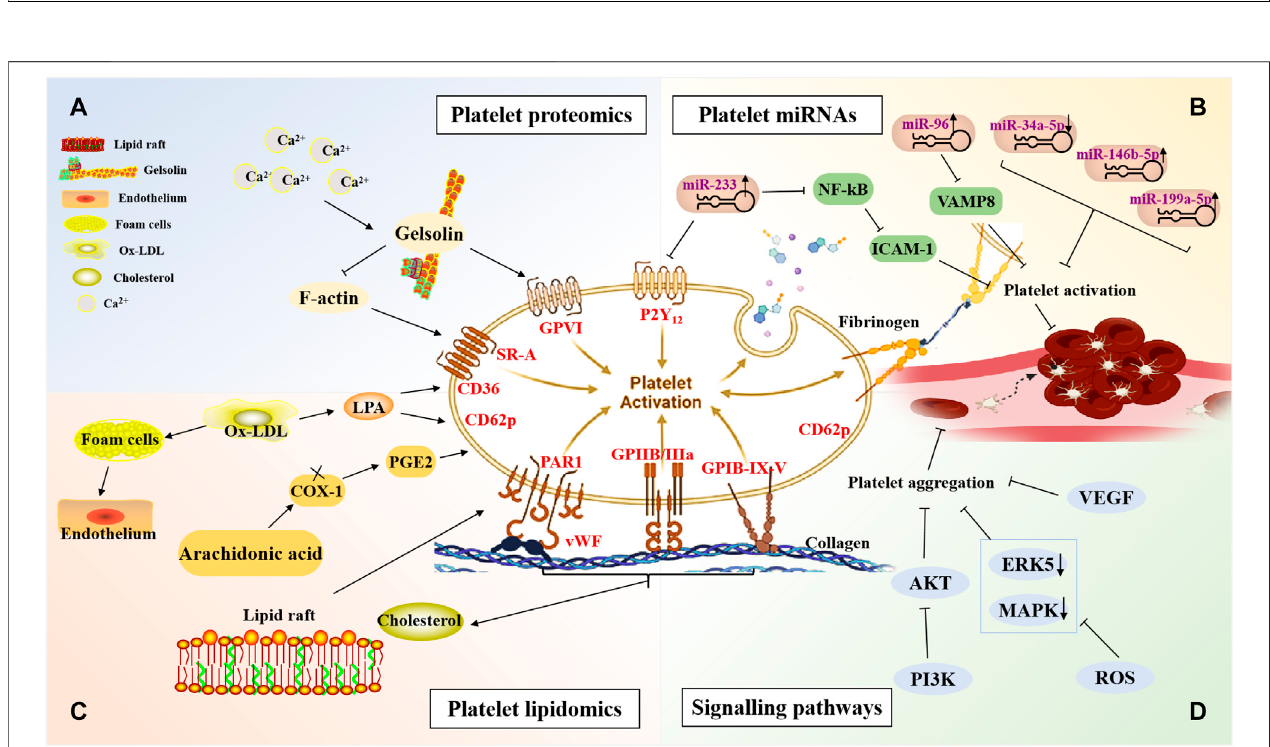
FIGURE 2 | The mechanisms against atherosclerotic cardiovascular diseases of blood-activating Chinese botanical drugs combined with anti-platelet drugs via platelet-related targets. This fi gure was created using BioRender.com. (A) The mechanisms of BAC botanical drugs combined with antiplatelet drugs identi fi ed through platelet proteomics. (B) The mechanisms of BAC botanical drugs combined with antiplatelet drugs involving platelet microRNAs. (C) The mechanisms of BAC botanical drugs combined with antiplatelet drugs identi fi ed through platelet lipidomics. (D) The mechanisms of BAC botanical drugs combined with antiplatelet drugs involving signalling pathways. PAR1, platelet aggregation rate 1; vWF, von Willebrand Factor; P2Y12 reaction units; VAMP8, vesicle-associated membrane protein 8; VCAM-1, vascular cell adhesion molecule-1; COX-1, cyclooxygenase-1; ICAM-1, intercellular adhesion molecule 1; LPA, lysophosphatidic acid; PGE2, prostaglandin E2; SR-A, scavenger receptor A; GPVI, glycoprotein VI; NF- κ B, nuclear transcription factor- κ B; VEGF, vascular endothlial growth factor; ERK5, Extracellular signal- regulatedproteinkinase5;MAPK,mitogen-activatedproteinkinases;PI3K,Phosphatidylinositol3-kinase;ROS,reactiveoxygenspecies;ox-LDL,Oxidisedlow-density lipoprotein.